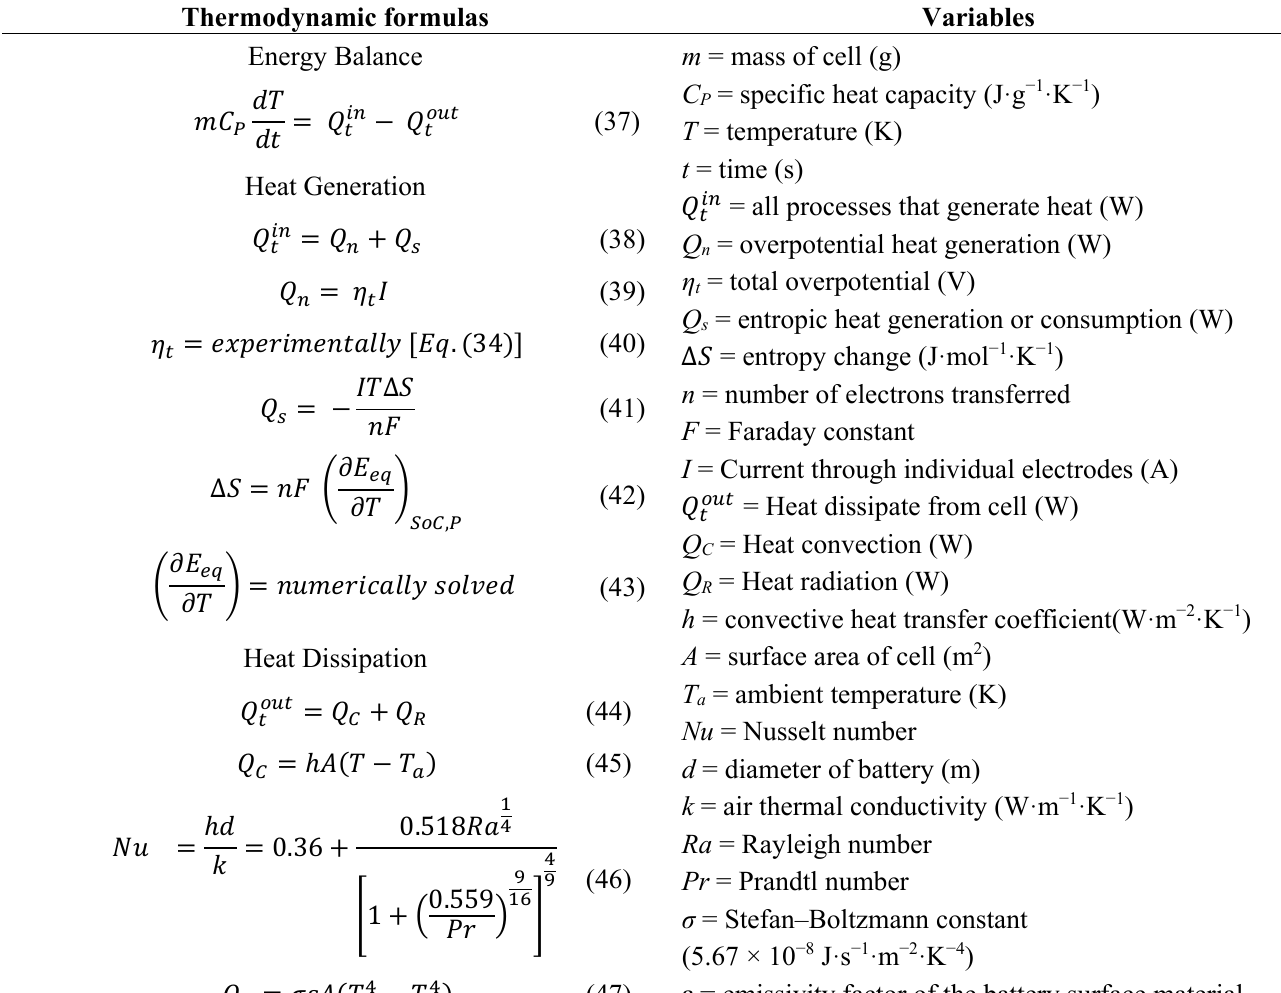
Table 3. Thermodynamic formulas for the adaptive thermal model